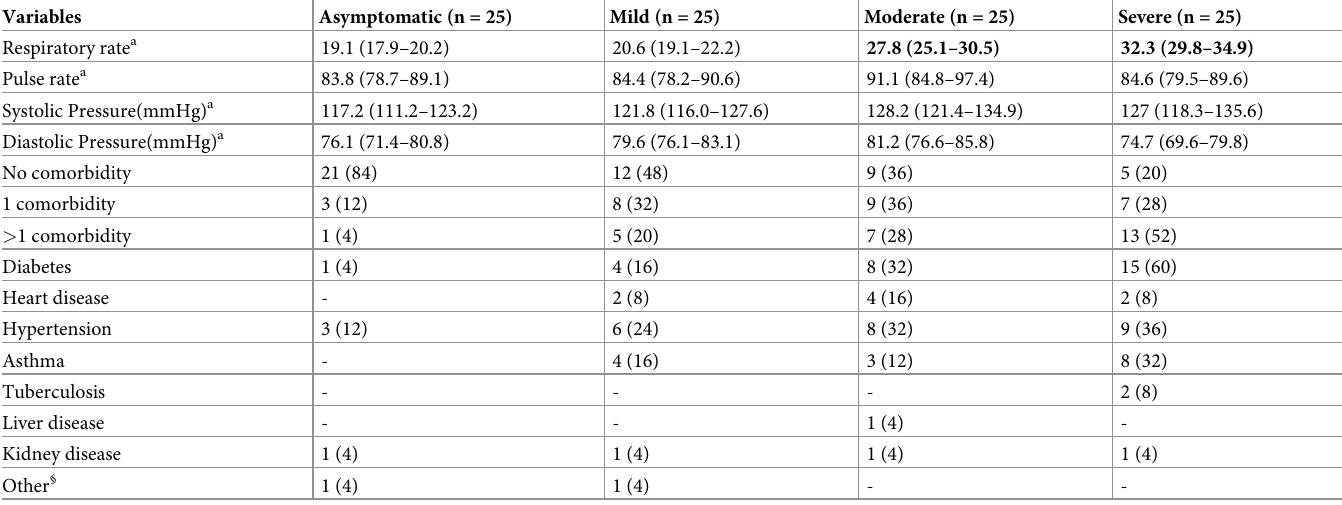
Bold values indicate significant difference among comparison groups. Comorbidity data presented as n (%) a Values given as mean (95% confidence interval, CI). § Other comorbidities included hypothyroidism and epilepsy.